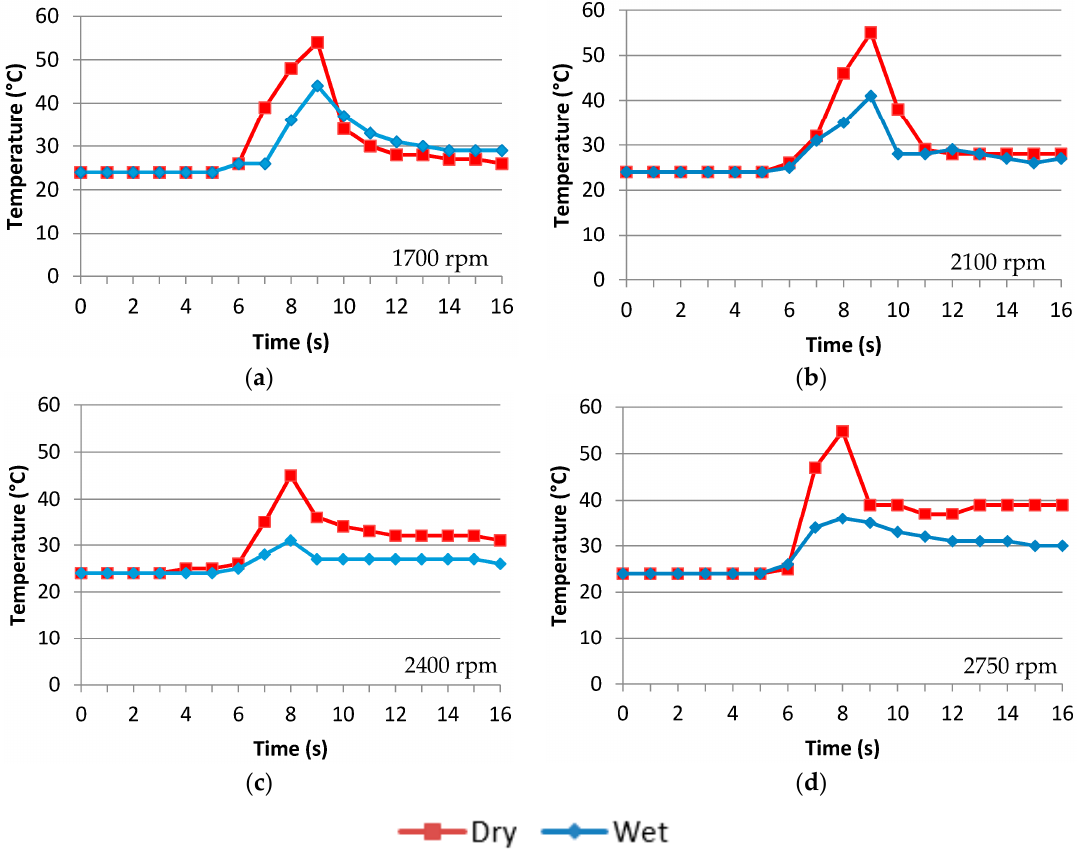
Figure 7. Wet and dry drilling temperature comparisons for initial spindle speeds of ( a ) 1700, ( b ) 2100, ( c ) 2400, and ( d ) 2750 rpm.